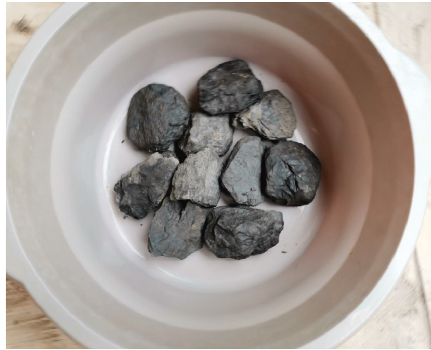
Figure 4: Photographs of the test